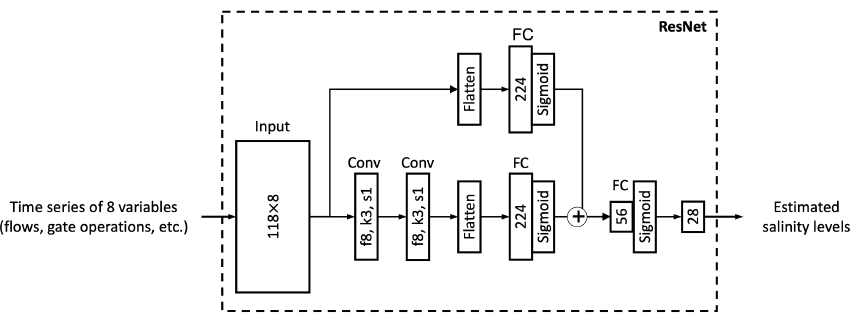
Figure 5. Architecture of the proposed MTL ResNet. In the convolutional layers, “f” represents number of filters, “k” represents kernel size, and “s” represents